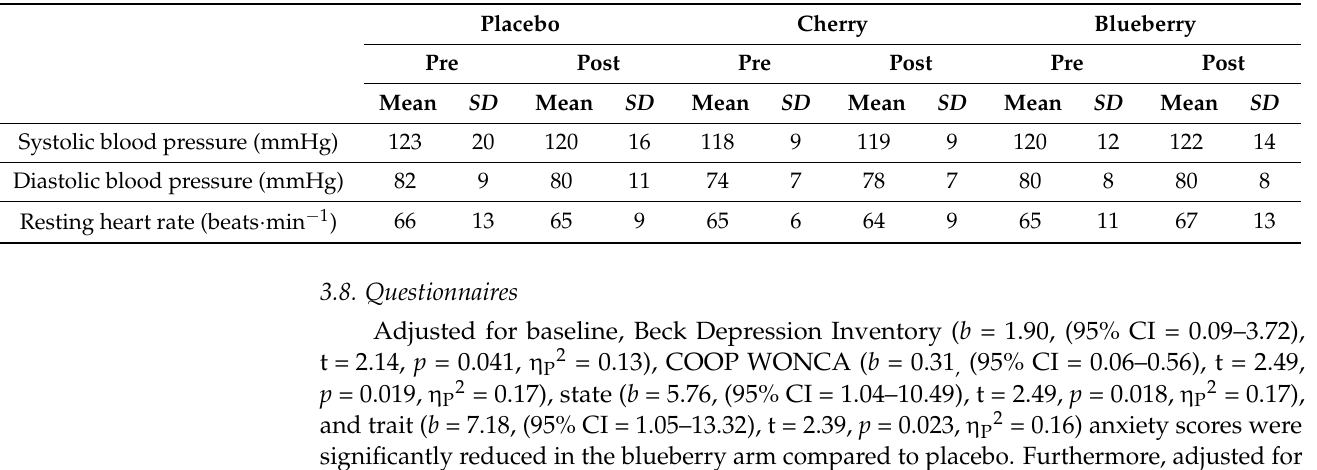
Table 6. Blood pressure and resting heart rate measurements as a function of each trial arm.